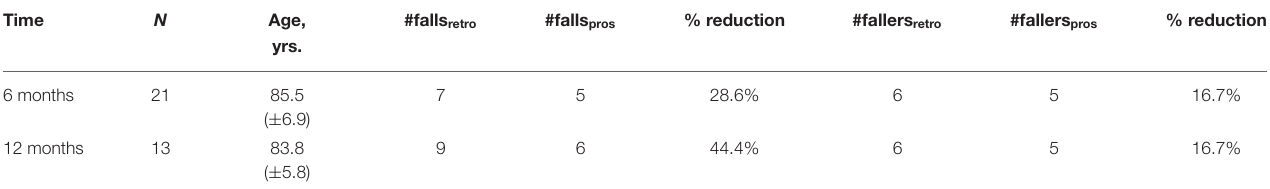
TABLE 3 | Comparison of number of falls and fallers data for participants with 6 and 12 months of actual fall tracking data with their equivalent fall history.